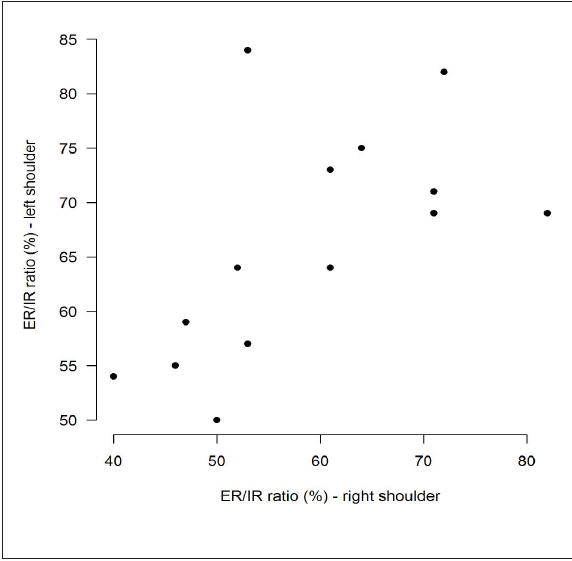
Figure 4 - Dispersion diagram of the right and left shoulder ER/IR ratio in the swimmers (r = 0.62; p <